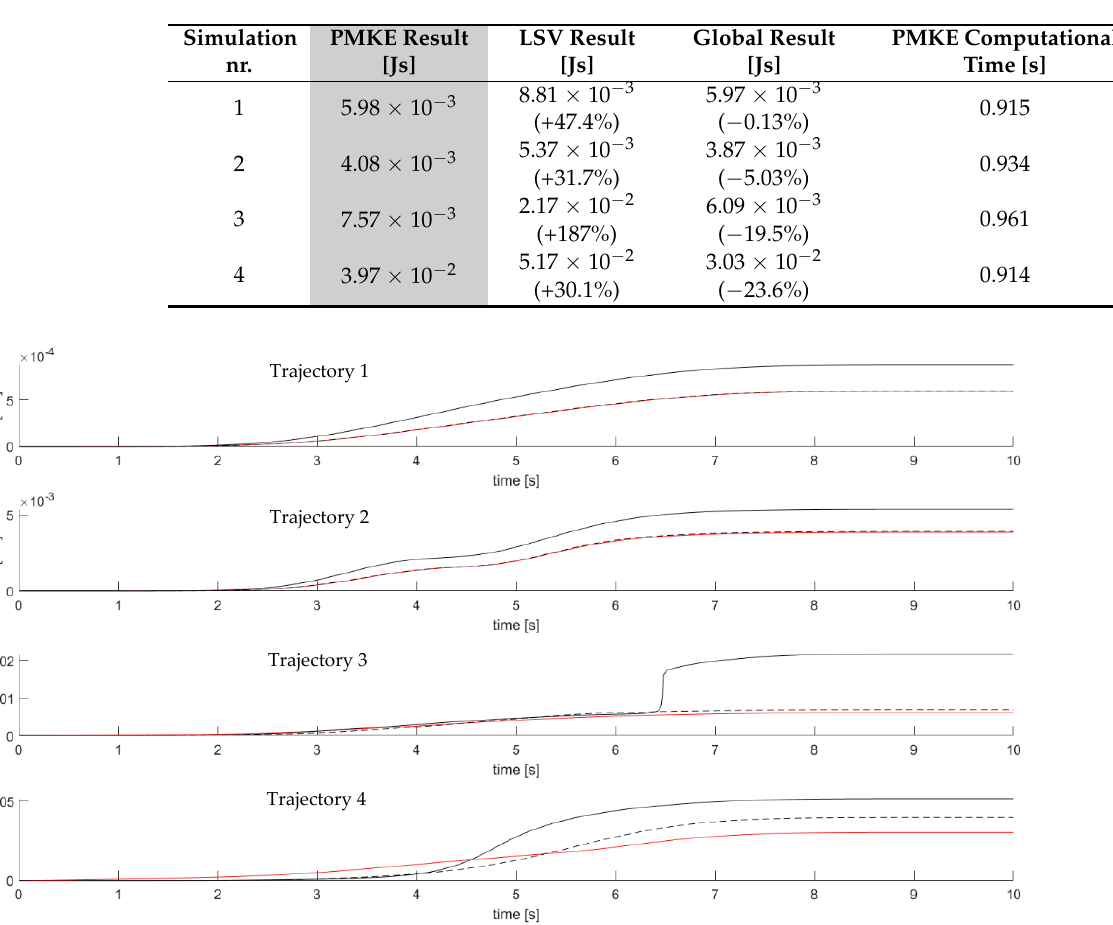
Figure 3. Kinetic energy integral plots for the four considered trajectories. PMKE: dashed black lines; LSV: continuous black lines; global optimal method: red lines.